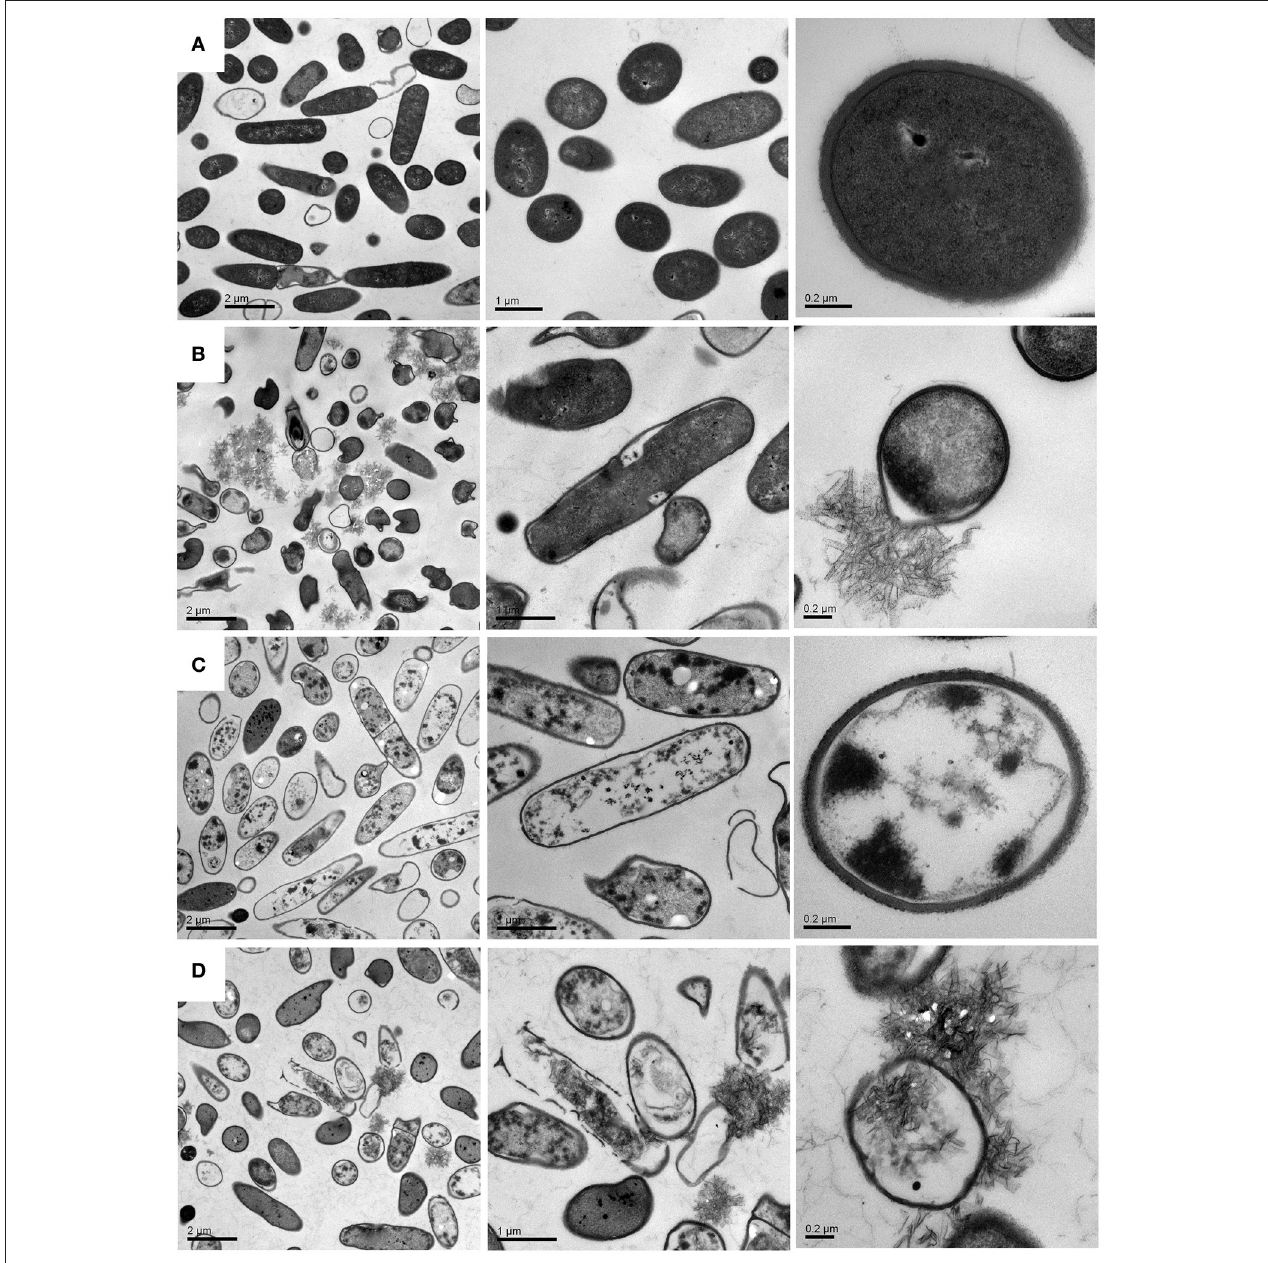
FIGURE 7 | TEM images of B. subtillis before (A) and after treated with CCNPs (B) , GS (C) , and CGPs (D) for 12h.